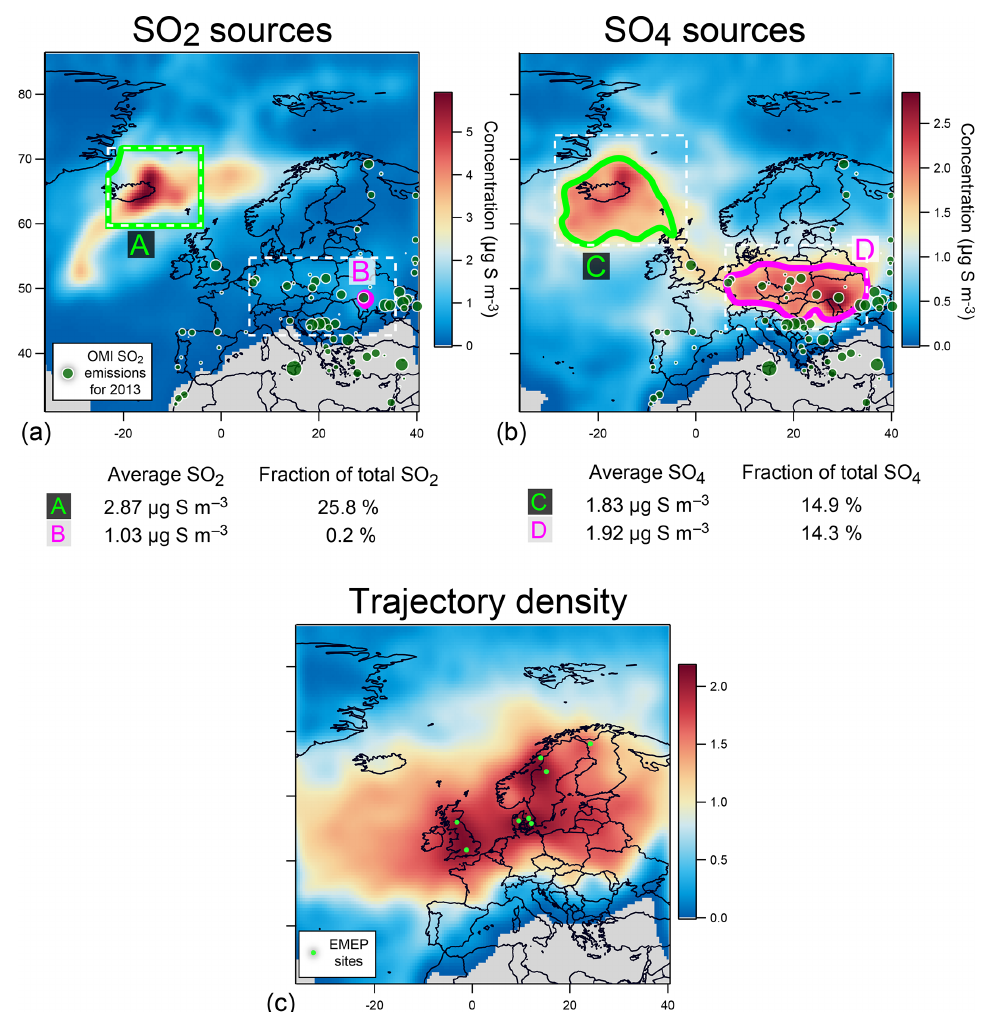
Figure 15. Multi-site concentration-weighted trajectory analysis for SO 2 and SO 4 mass concentrations measured in September–October 2014 at a set of eight selected EMEP stations in northern Europe (shown in Fig. 14): retrieved source mass concentrations (µgSm − 3 ) of (a) SO 2 and (b) corrected SO 4 (i.e. non-marine SO 4 ), (c) trajectory density (log of residence time, no unit) with the location of stations (light green circles). Contribution to the widespread atmospheric pollution of Icelandic volcanism (A and C green areas) and anthropogenic (B and D pink areas) sources is calculated in the white dashed rectangles, using an edge detection at 1 and 1.5µgSm − 3 for SO 2 and SO 4 , respectively. SO 2 emission sources for 2013 derived from OMI satellite sensor observations (from Fioletov et al., 2016) are indicated by dark green